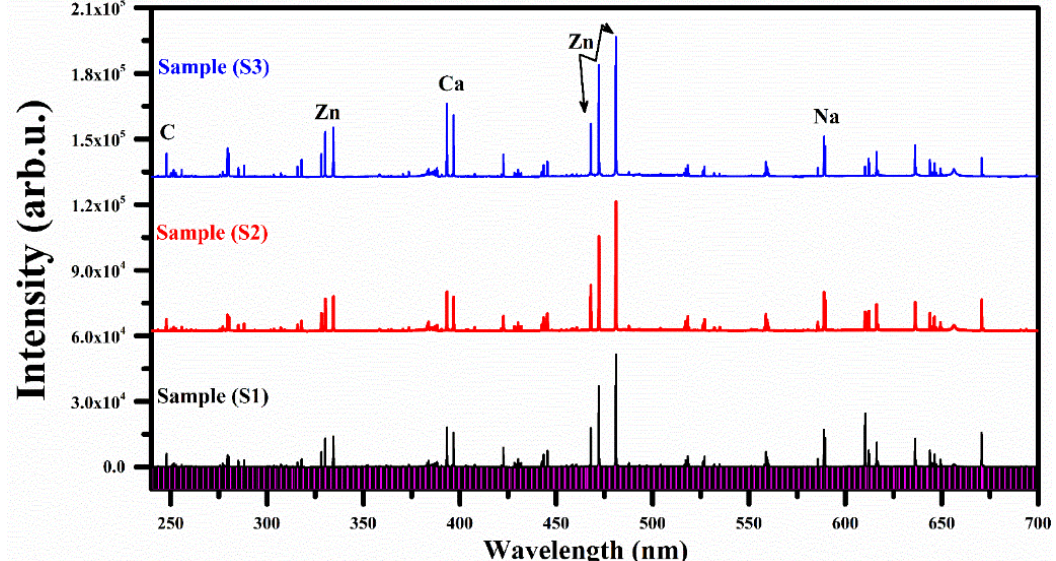
Figure 6. Average LIBS spectra of plant-biochar samples (S1, S2 and S3).